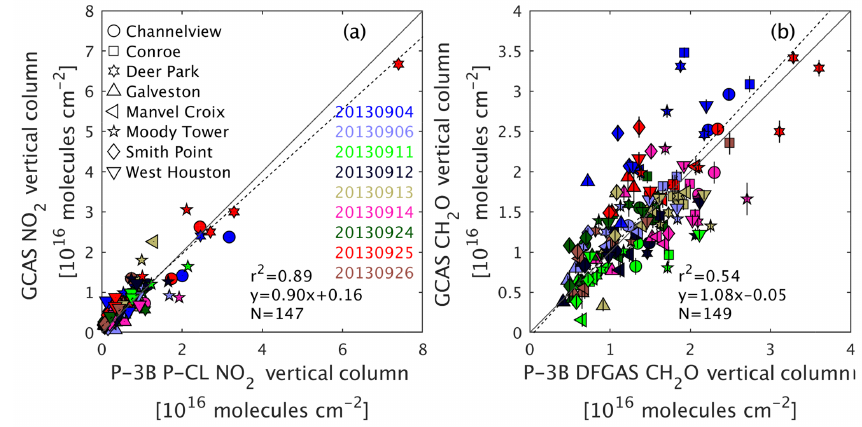
Figure 7. Columns derived from in situ measurements of (a) NO 2 from the chemiluminescence instrument and (b) CH 2 O from the DFGAS instrument on the P-3B aircraft compared with vertical columns measured by the GCAS instrument, over 9 days during the DISCOVER-AQ Texas campaign. Each GCAS vertical column is the mean of all retrieved cloud-free GCAS columns below the aircraft within 5km and 1h of its coincident P-3B spiral center. GCAS air mass factors are determined using modeled CMAQ profiles. The solid line represents the 1:1 ratio. The dotted line represents the reduced major axis linear regression. Error bars represent the uncertainty in the GCAS mean column due to retrieval noise from the observations used to calculate a mean column (typically several hundred at 250m × 500m resolution); in the case of NO 2 , this uncertainty is generally negligible due to low relative error. Column precisions for P-3B observations are approximately 2 × 10 13 moleculescm − 2 (NO 2 ) and 6 × 10 13 moleculescm − 2 (CH 2 O). Uncertainties from spatial variability and measurement accuracy are discussed in the